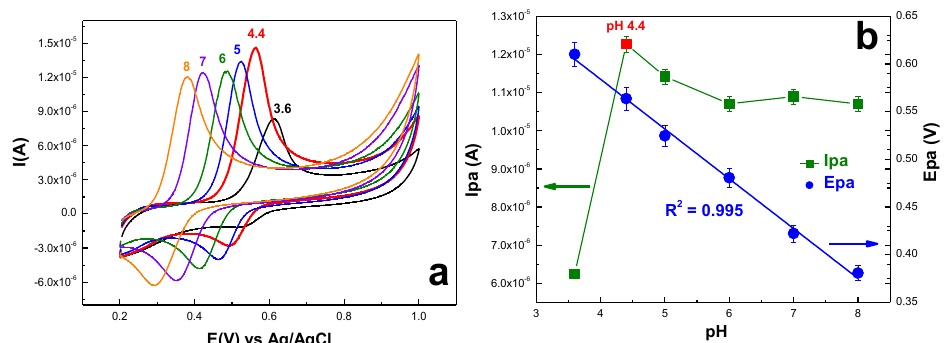
Figure 5. ( a ) Voltammetric response of exf ‒ NGr/GCE surface in buffer solutions containing 100 µM AMP at different pH values (3.6, 4.4, 5.0, 6.0, 7.0, and 8.0); scan rate: 10 mV/s; ( b ) variation of the peak current with pH value (green curve) and linear dependence of peak potential vs. pH value (blue curve).